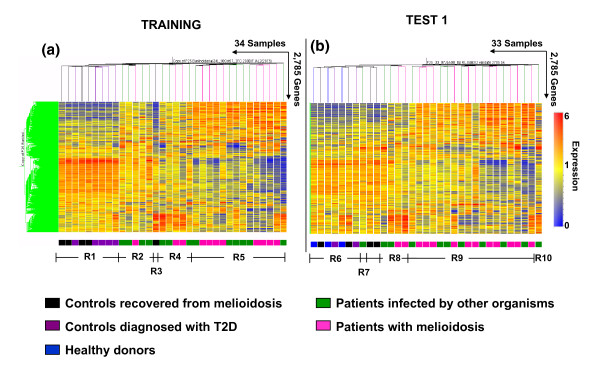
Unsupervised hierarchical clustering of blood transcriptional profiles of septic patients. Transcripts with 2-fold over- or under-expression compared with the median of all samples and differential expression values greater than 200 from the median for each gene in at least 2 samples in the training set were selected for unsupervised analysis (n = 2,785 transcripts). (a) A heatmap resulting from hierarchical clustering of transcripts and conditions (subjects) was generated for the training set. (b) The same gene tree of these 2,785 transcripts was then used to generate a heatmap for the first independent test set (test set 1) using hierarchical clustering of conditions as before. The color conventions for heatmaps are as follows: red indicates over-expressed transcripts; blue represents underexpressed transcripts; and yellow indicates transcripts that do not deviate from the median. Study group is marked as follows: patients with melioidosis are indicated by pink rectangles; patients with sepsis due to other organisms by green rectangles; uninfected controls who recovered from melioidosis by black rectangles; T2D patients by purple rectangles; and healthy donors by blue rectangles. This unsupervised hierarchical clustering of blood transcriptional profiles was observed to segregate into five distinct regions in both training (regions R1 to R5) and test sets (regions R6 to R10).